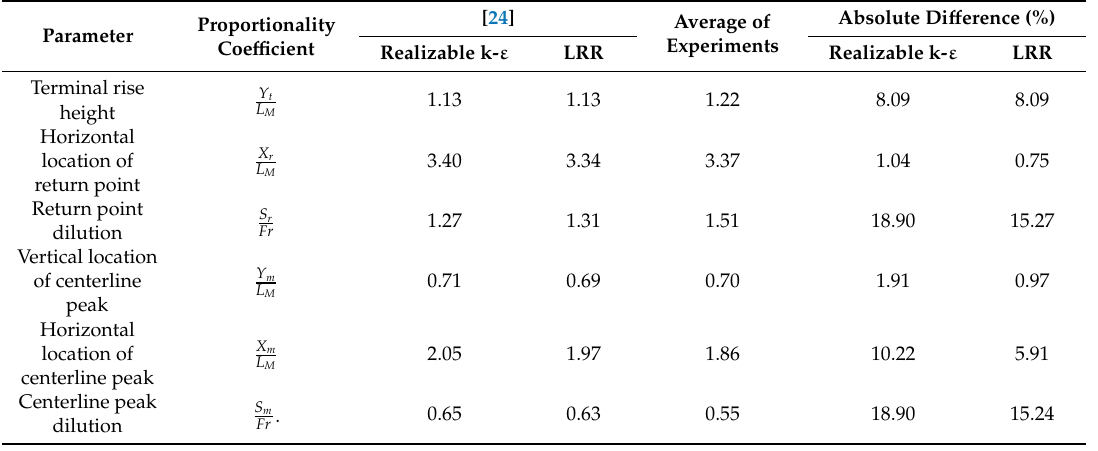
inclined jet (Source: [24]).